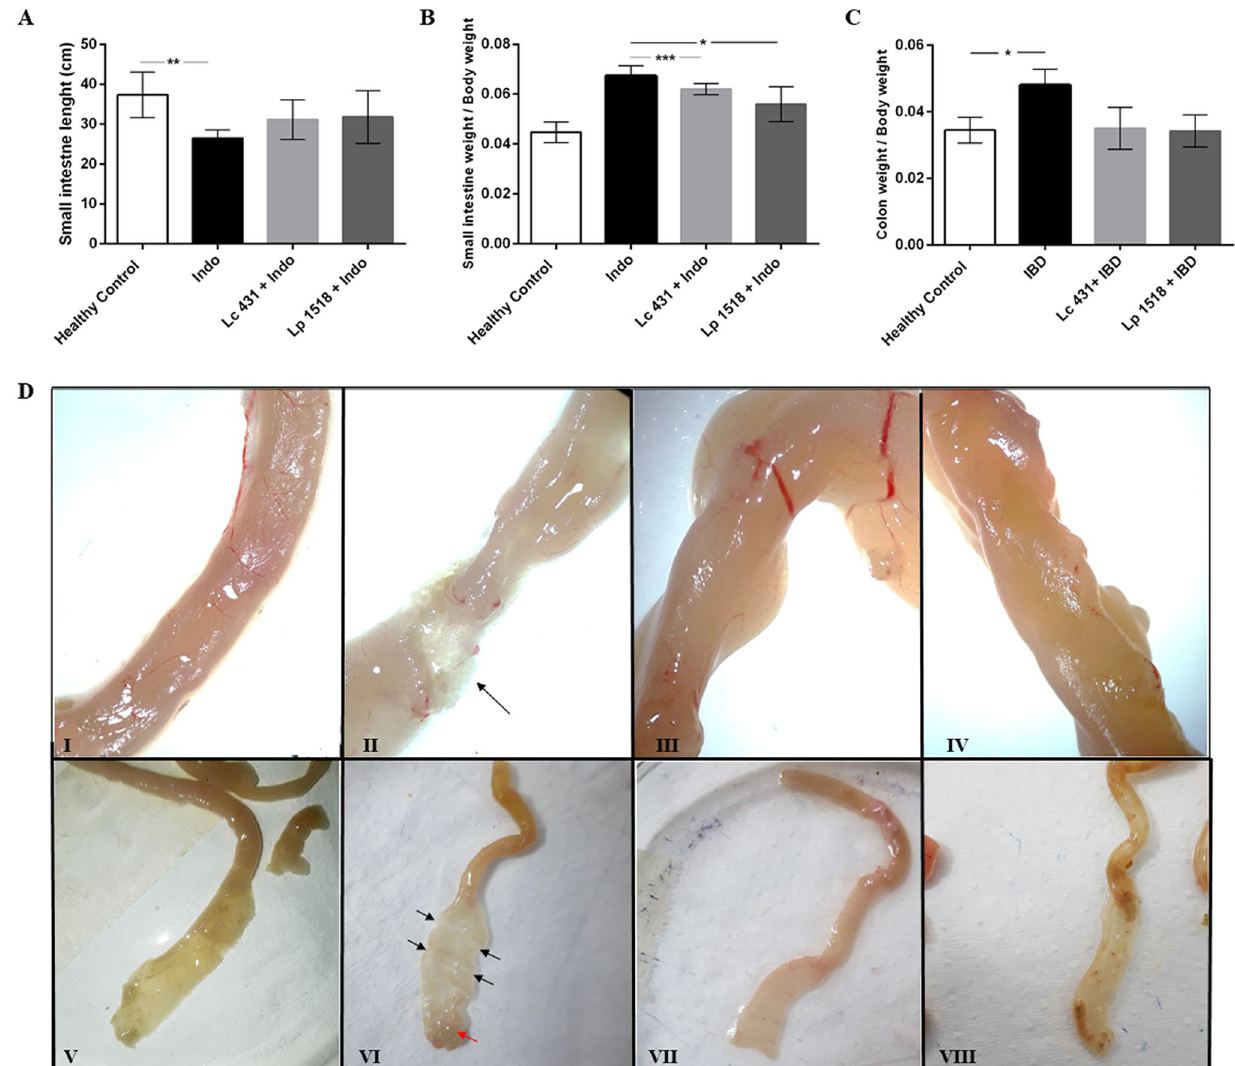
Figure 2. Intestinal damage in mice treated with indomethacin and supplemented with probiotics. Balb/c mice supplemented with Lactobacillus casei CRL 431 (Lc 431), Lactobacillus paracasei CNCM I-1518 (Lp 1518), or water, for 7 and 5 days, received indomethacin on the last two days. On day 8 mice were euthanized and the following parameters were evaluated: ( A ) small intestine length; ( B ) the ratio between the weight of the small intestine and the body of each animal; and ( C ) the ratio between the weight of each large intestine and the body of the animal. The line at the top of the bars indicates the comparison between the two groups. * p < 0.05, ** p < 0.01, *** p < 0.001. ( D ) Representative photography of the small intestine of: Panel I and V- Healthy control; Panel II and VI- Indo; Panel III and VII- Lc 431 + Indo; and Panel IV and VIII- Lp 1518 + Indo mice, revealing the presence of ulcers (black arrows) and a mucosa with granular appearance (red arrows) in mice on a conventional diet treated with indomethacin. I-IV images were taken under observation with a Leica ES2 Stereo Microscope with 10 × High Eyepoint. V-VIII are images of the intestine after cutting them inflammation on a conventional diet showed an important hyperplasia of the crypt compared to healthy control mice ( p < 0.001) (Fig. 3G–J). Oral probiotic supplementation in indomethacin‑induced intestinal inflammation reinforces the intestinal barrier by increasing antimicrobial activity and Paneth cells. Considering indo- methacin administration used to impairs the functions of the gut barrier, the number of Paneth and Goblet cells was determined in all the experimental animals. We observed a significant increase in Paneth cells in Lc 431 + Indo and Lp 1518 + Indo compared to the Indo group ( p < 0.05) (Fig. 4A). Moreover, the number of mucin- secreting Goblet cells was significantly reduced in Indo (4.43 ± 0.33, mean ± S.E.M) compared to healthy controls ( p < 0.0001). Importantly, oral probiotic supplementation was able to greatly increase the number of Goblet cells (6.41 ± 0.31 and 5.32 ± 0.28, mean ± S.E.M; for Lc 431 + Indo and Lp 1518 + Indo groups, respectively) (Fig. 4B).